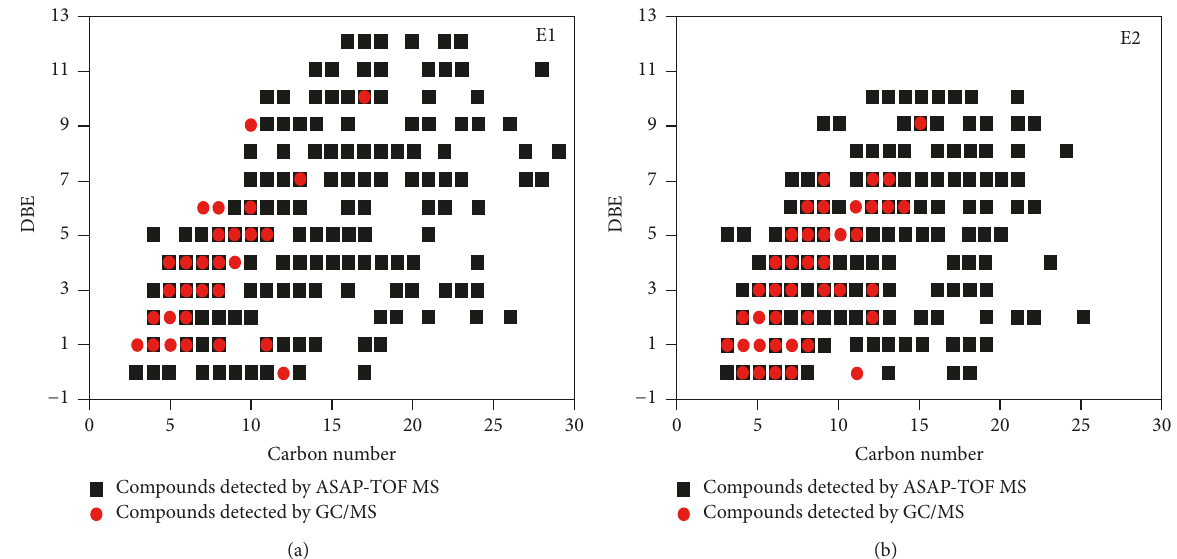
Figure 5: DBE versus carbon number of n -hexane and CCl 4 extractable species in a rice husk biooil using atmospheric solids analysis probe mass spectrometry